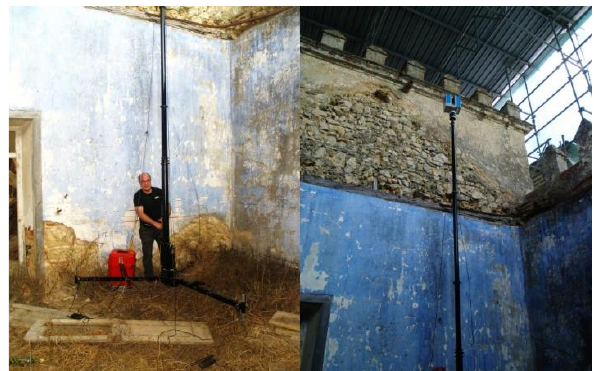
Figure 7. Using a hydraulic mast to reach the higher parts of the building.